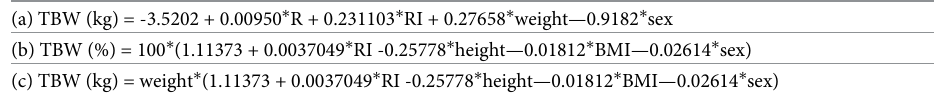
Table 4. Best predictive equations for TBW (kg) and TBW(%). (a) TBW (kg) = -3.5202 + 0.00950 * R + 0.231103 * RI + 0.27658 * weight—0.9182 * sex (b) TBW (%) = 100 * (1.11373 + 0.0037049 * RI -0.25778 * height—0.01812 * BMI—0.02614 * sex) (c) TBW (kg) = weight * (1.11373 + 0.0037049 * RI -0.25778 * height—0.01812 * BMI—0.02614 * sex) R , resistance ( O ) at 50 kHz; RI , resistance index, height 2 /resistance (cm 2 / O ), TBW , total body water Weight is entered in kg, height in m, and sex coded: boys = 0, girls = 1. Equation (c), which predicts TBW (kg) by multiplying TBW (%) by weight, has better predictive performance than (a), which models TBW (kg)